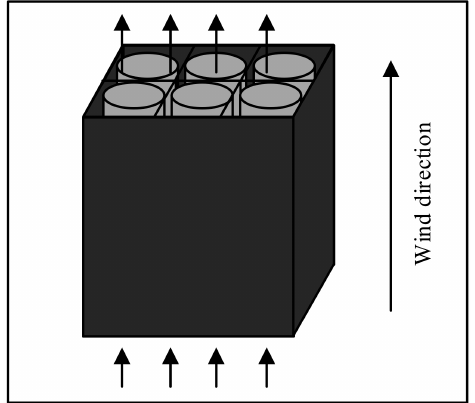
Figure 2. Finned air-cooling thermal management